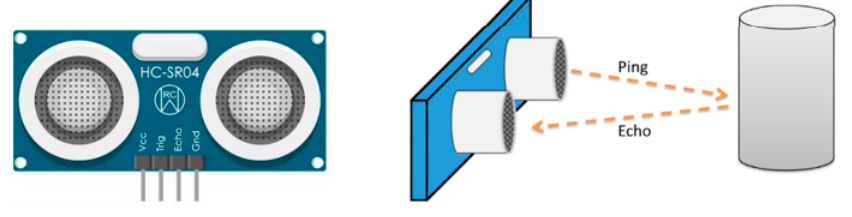
Figure 5. The ultrasonic sensor.